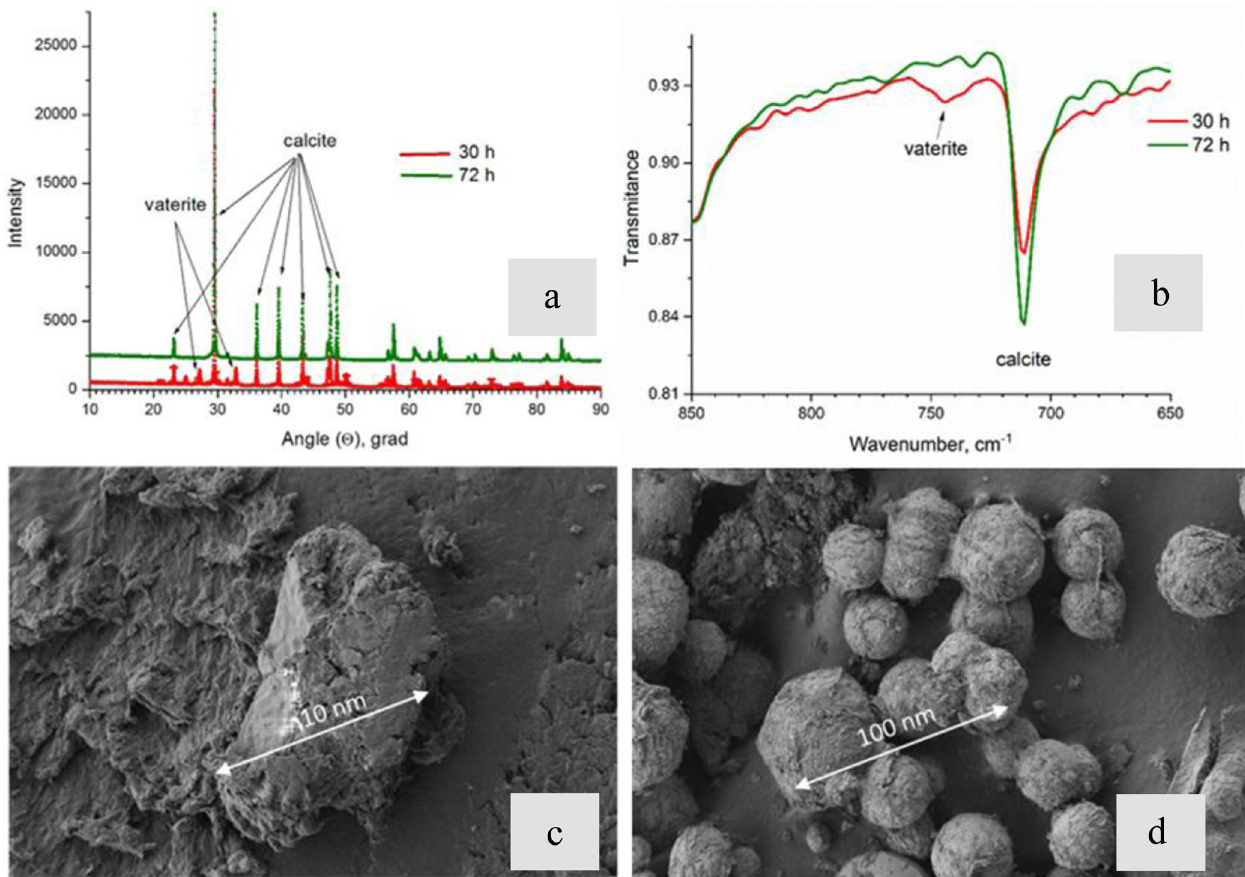
Fig. 7 Mineral analysis of CaCO3 precipitates induced by the B. cereus during the growth in the B4-CaUr medium. a X-ray diffraction patterns of the samples shows vaterite peak loss after 30 h. b FTIR spectra of precipitates at different times of growth shows polymorph transition from vaterite to calcite. c , d SEM images of CaCO 3 particles induced by B. cereus at 24 and 72 h after inoculation,